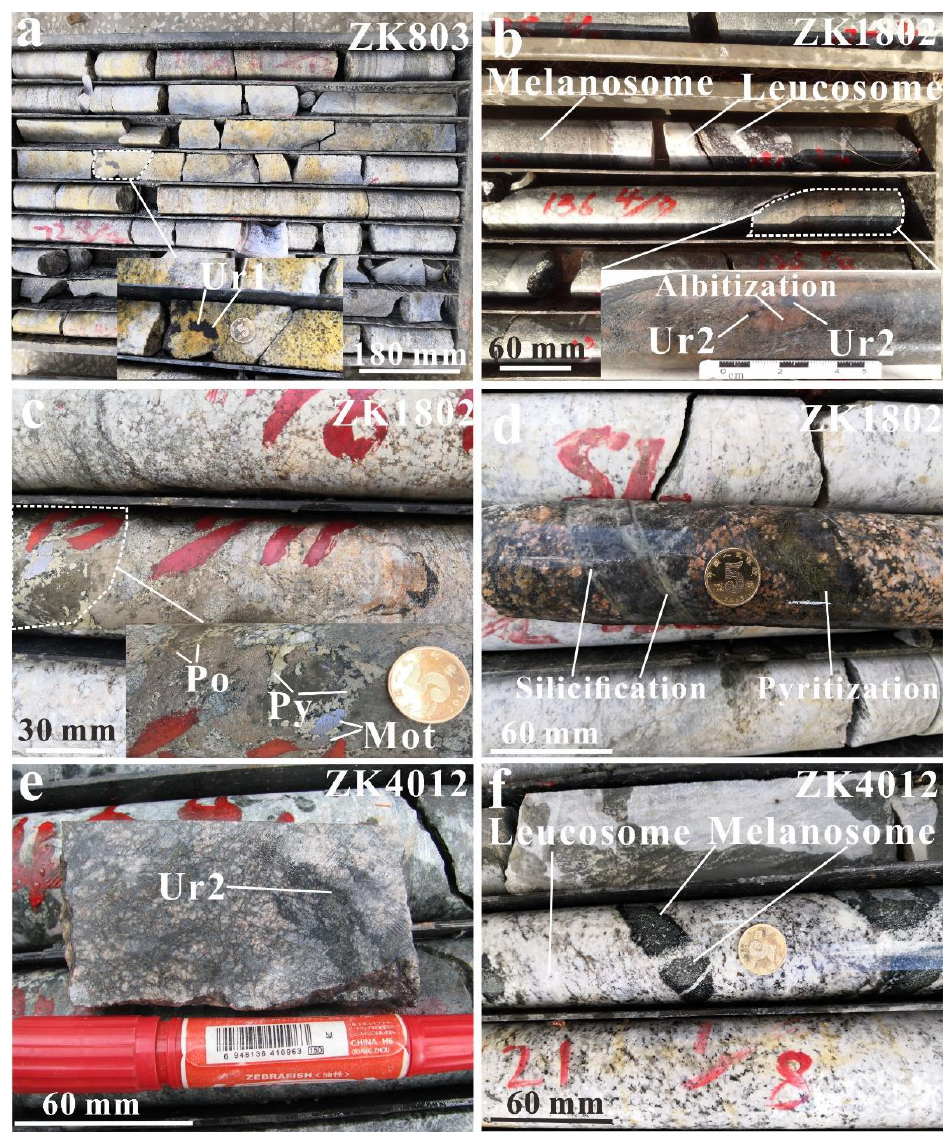
Figure 4. Photos of the drill cores from drill holes ZK803, ZK1802, and ZK4012 in the Datian uranium deposit. ( a , b , e ) Uraninite hosted in biotite plagioclase migmatite; ( c ) pyrite, pyrrhotite, and molybdenite in drill hole ZK1802; ( d ) pyritization and silicification in drill hole ZK1802; ( f ) biotite plagioclase migmatite in drill hole ZK4012. Mineral abbreviations: Ur — uraninite; Po — pyrrhotite; Py — pyrite; Mot — molybdenite.